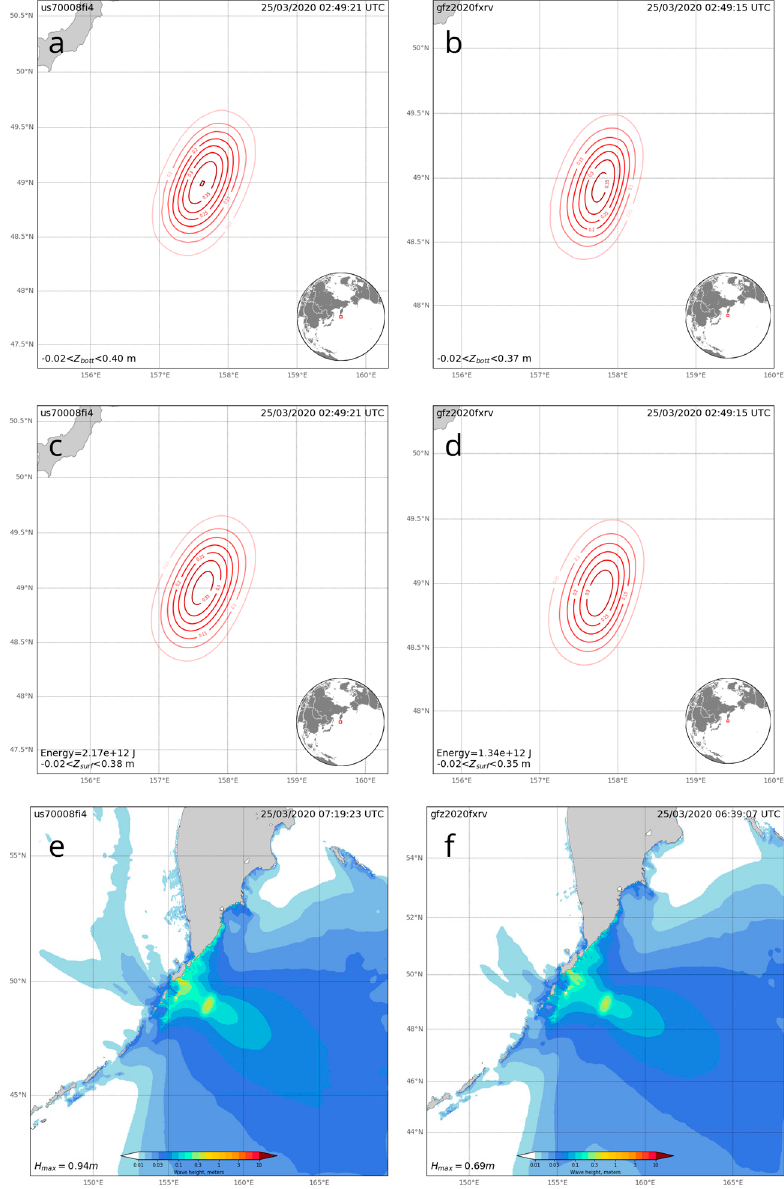
Figure 5. Results of processing by the system of the tsunamigenic earthquake on 25 March 2020 in the Northern Kurils. Subfigures show the coseismic bottom displacements ( a , b ), the initial elevations of the water surface at the tsunami source ( c , d ) and distribution of the maximum heights of tsunami waves ( e , f ). Earthquake data origin: USGS (left column) and GEOFON (right column).